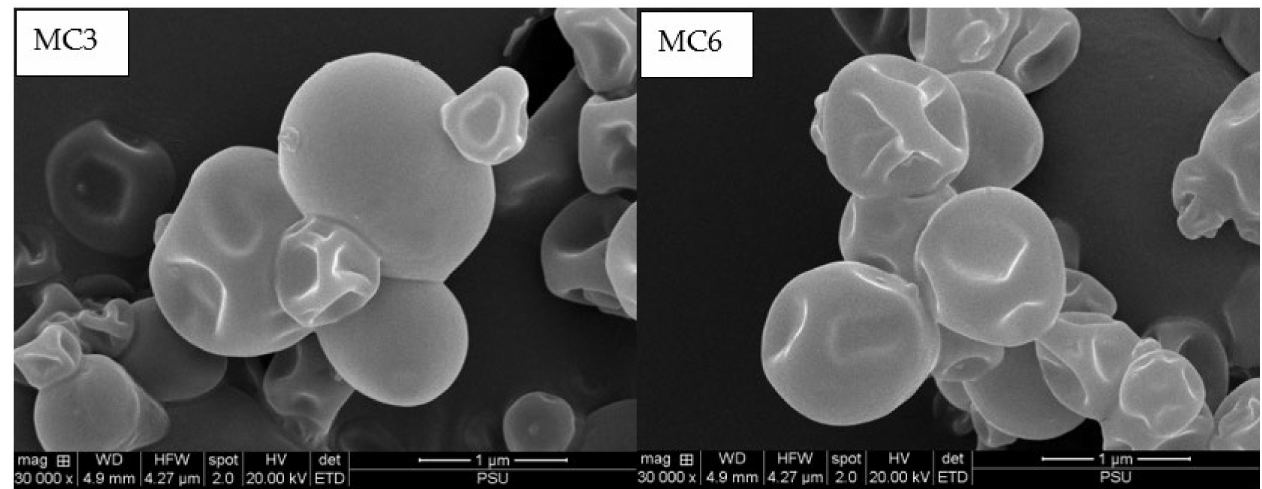
Figure 1. Scanning electron micrographs of spray-dried microcapsules loaded with SO-TSO having MBPI and SA as wall materials. SO-TSO: mixture of shrimp oil-tea seed oil (1:1); MBPI: mung bean protein isolate; SA: sodium alginate; MC3: spray-dried microcapsules containing 3% MBPI, 0.3% SA, and 0.5% ( w / w ) SO-TSO; MC6: spray-dried microcapsules containing 3% MBPI, 0.3% SA, and 0.75% ( w / w )